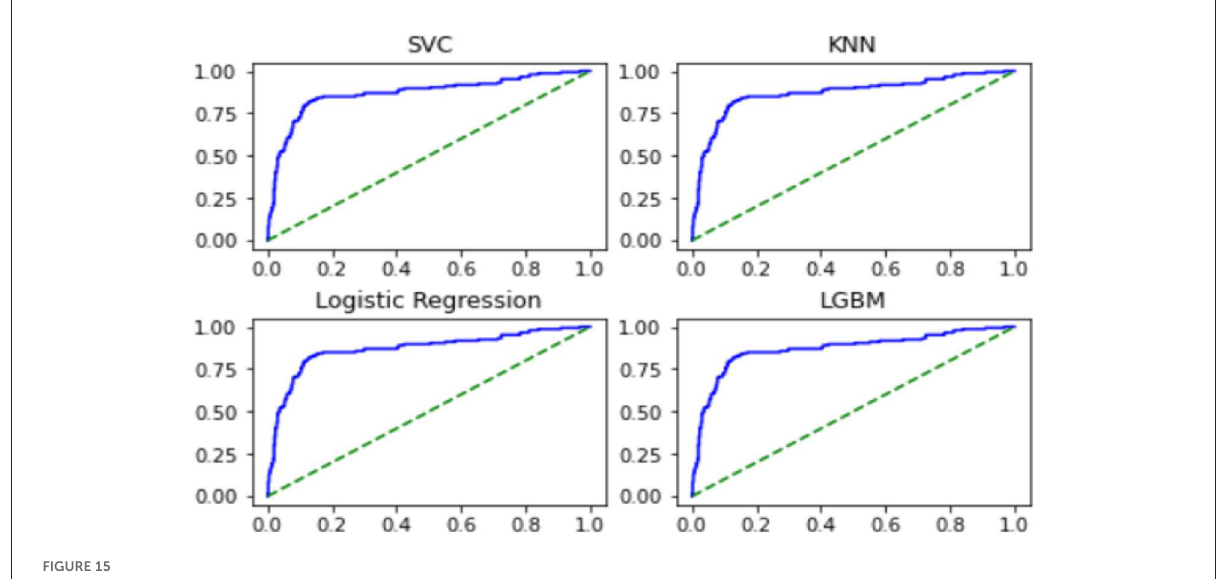
FIGURE15 ROC curve of TOP-4